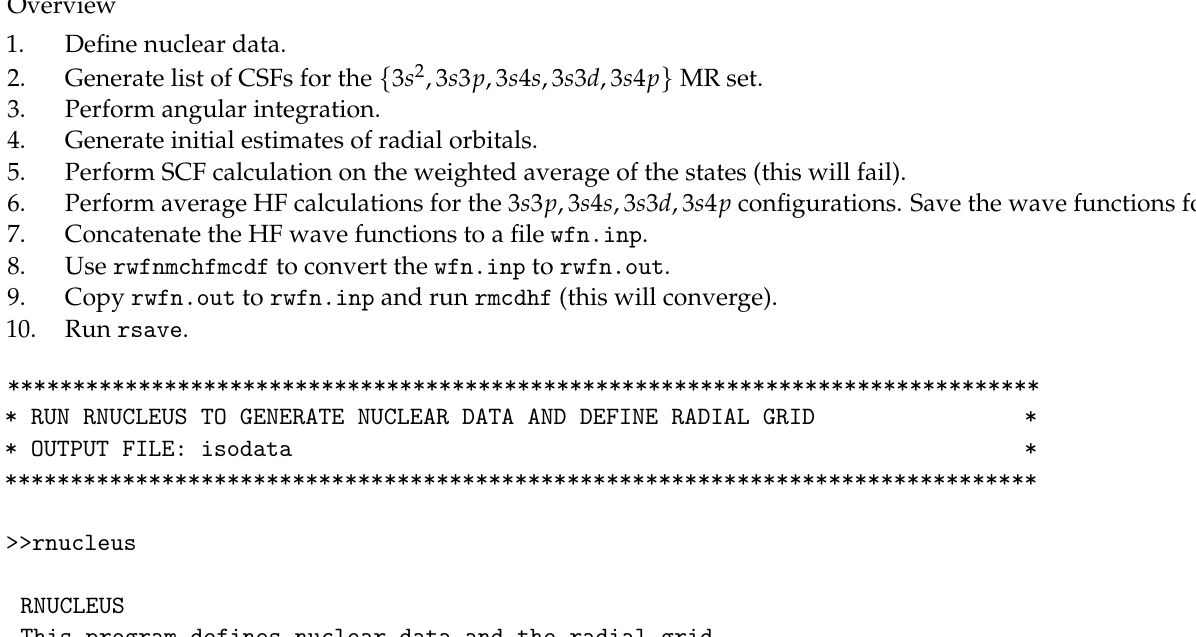
2 P o − 2 S − 2 S 1/2 and 1/2 1/2 3/2